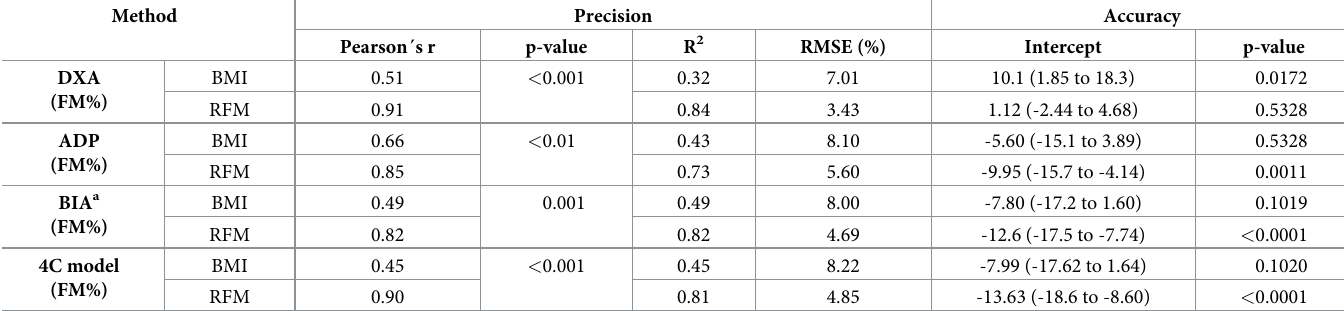
Table 3. Linear regression equation comparison of BMI and RFM against FM% obtained from the body composition methods.